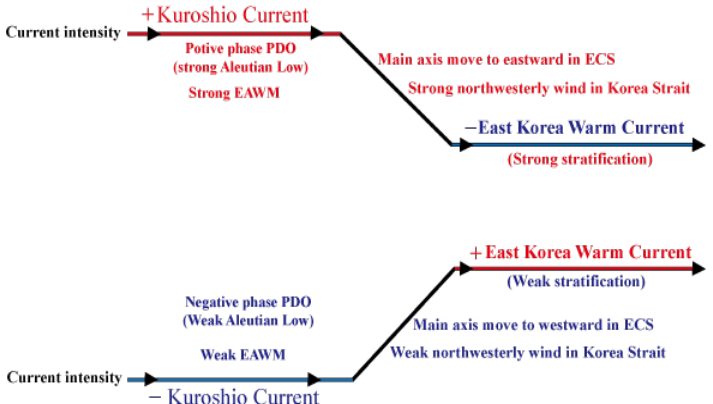
Figure 9. Schematic of the relationship between intensity of Kuroshio Current and East Korea Warm Current. Abbreviations: ECS, East China Seas; EAWM, East Asian Winter Monsoon; PDO, Pacific Decadal Oscillation.